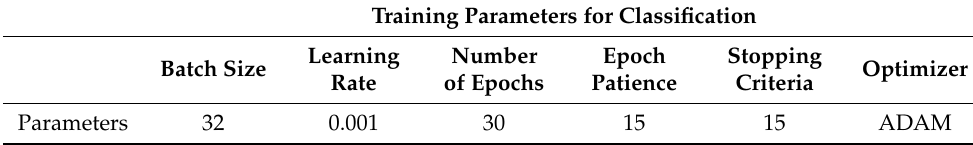
Table 4. Details of training parameters for classification.